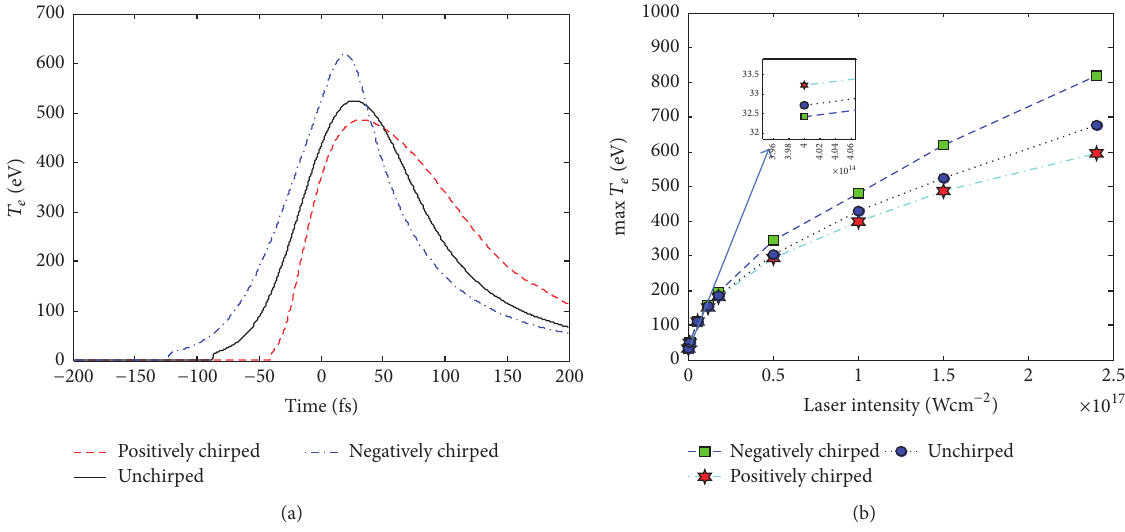
Figure 4: (a) Time evolution of the electron energy at the different laser pulse shapes with 1.5 × 10 17 Wcm −2 laser intensity, 40fs duration pulse, and wavelength of 825 nm. (b) The variations in the maximum electron energy at the different laser pulse shapes in different laser intensities with 40fs duration pulse and wavelength of 825 nm.